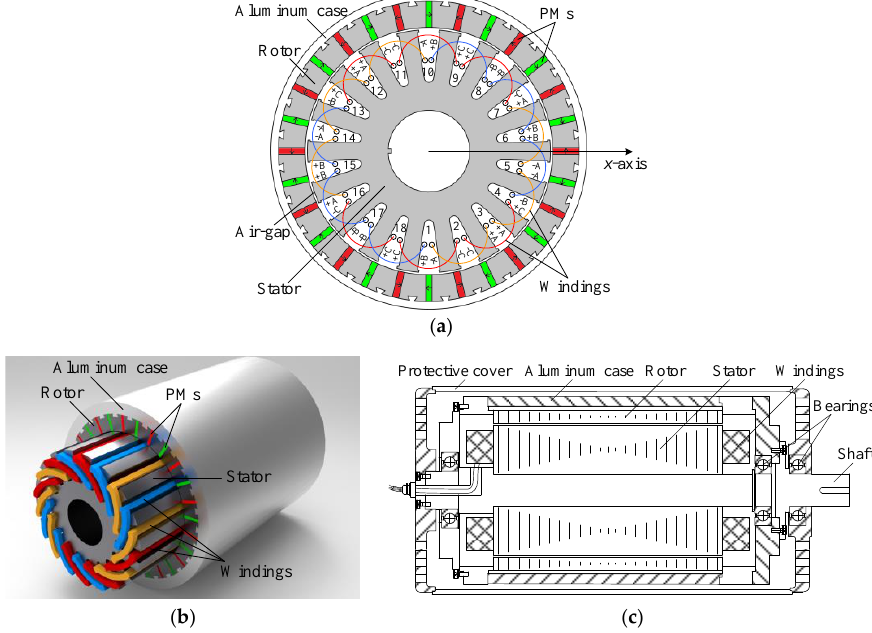
Figure 1. Configurations of the proposed field-modulated permanent-magnet (FMPM) machine. ( a ) Cross-section; ( b ) three-dimensional global model; and ( c ) assembly diagram.